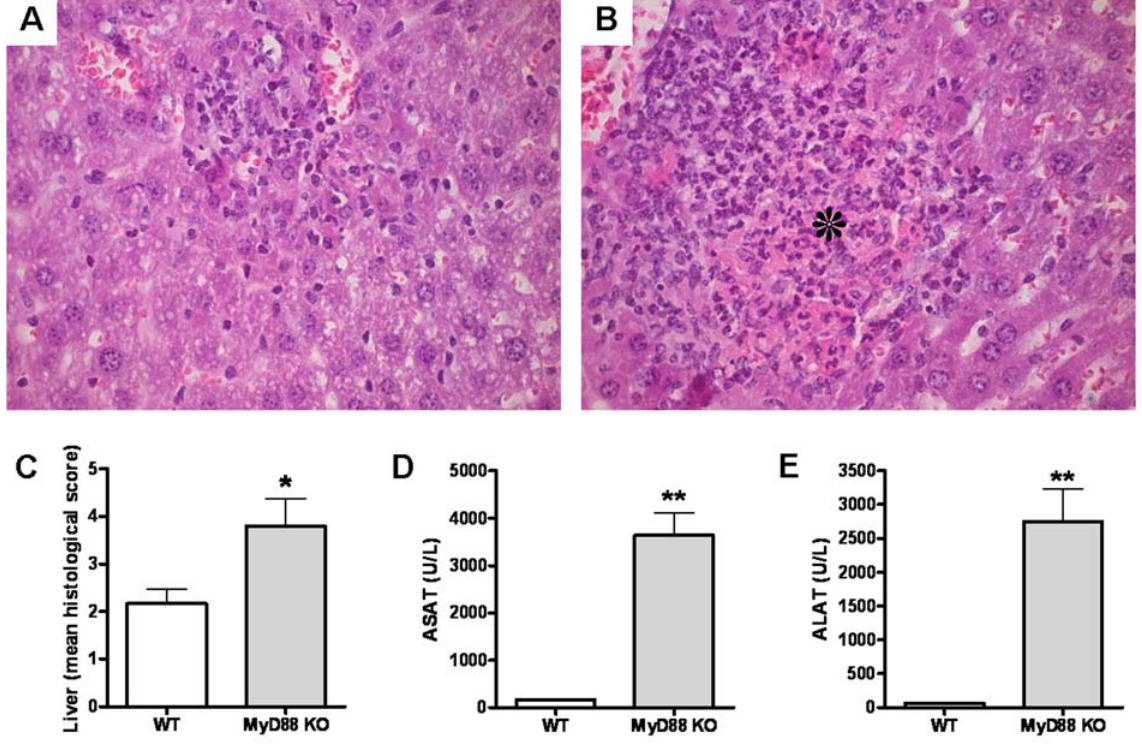
Figure 6. Enhanced liver damage in MyD88 KO mice. Representative hematoxylin- and eosin-stained liver histology slides for WT (A) and MyD88 KO (B) mice at 72 h after inoculation with 5 6 10 2 CFU B. pseudomallei show more inflammation and foci of necrosis (as indicated by the asterisk) in the livers derived from MyD88 KO animals compared to WT controls (original magnification, 6 400) corresponding with higher pathology scores (see Methods section) (C) . At 72 h after inoculation MyD88 KO mice also showed enhanced hepatic injury, as reflected by the plasma concentrations of aspartate aminotransferase (ASAT) (D) and alanine aminotransferase (ALAT) (E) . Data are mean 6 SEM (n=5–6 per group); U/L, units per liter; * P , 0.05; ** P , 0.01.